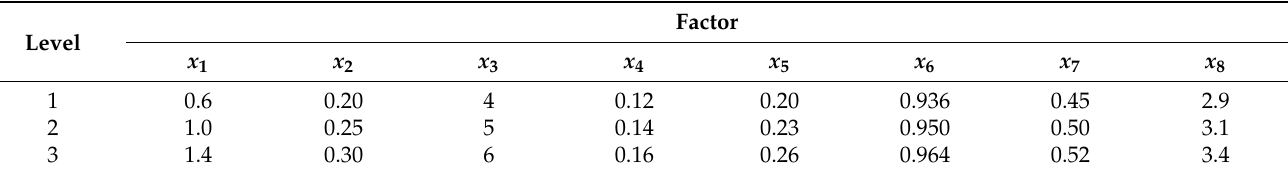
Table 5. Orthogonal factor